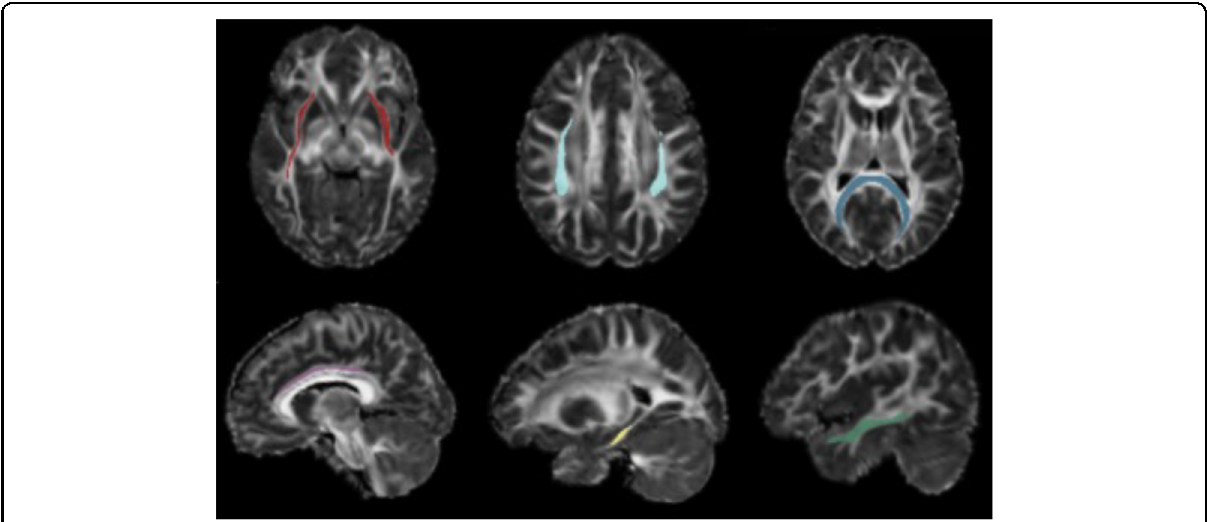
Fig. 1 White matter bundle con fi dence maps. Thresholded and binarized white matter bundle con fi dence maps overlaid on a subject ’ s FA map registered to MNI space. Red: inferior fronto-occipital fasciculus; light blue: superior longitudinal fasciculus; dark blue: forceps major; purple: cingulum bundle-cingulate gyrus portion; yellow: cingulum bundle-hippocampal portion; dark green: inferior longitudinal fasciculus.